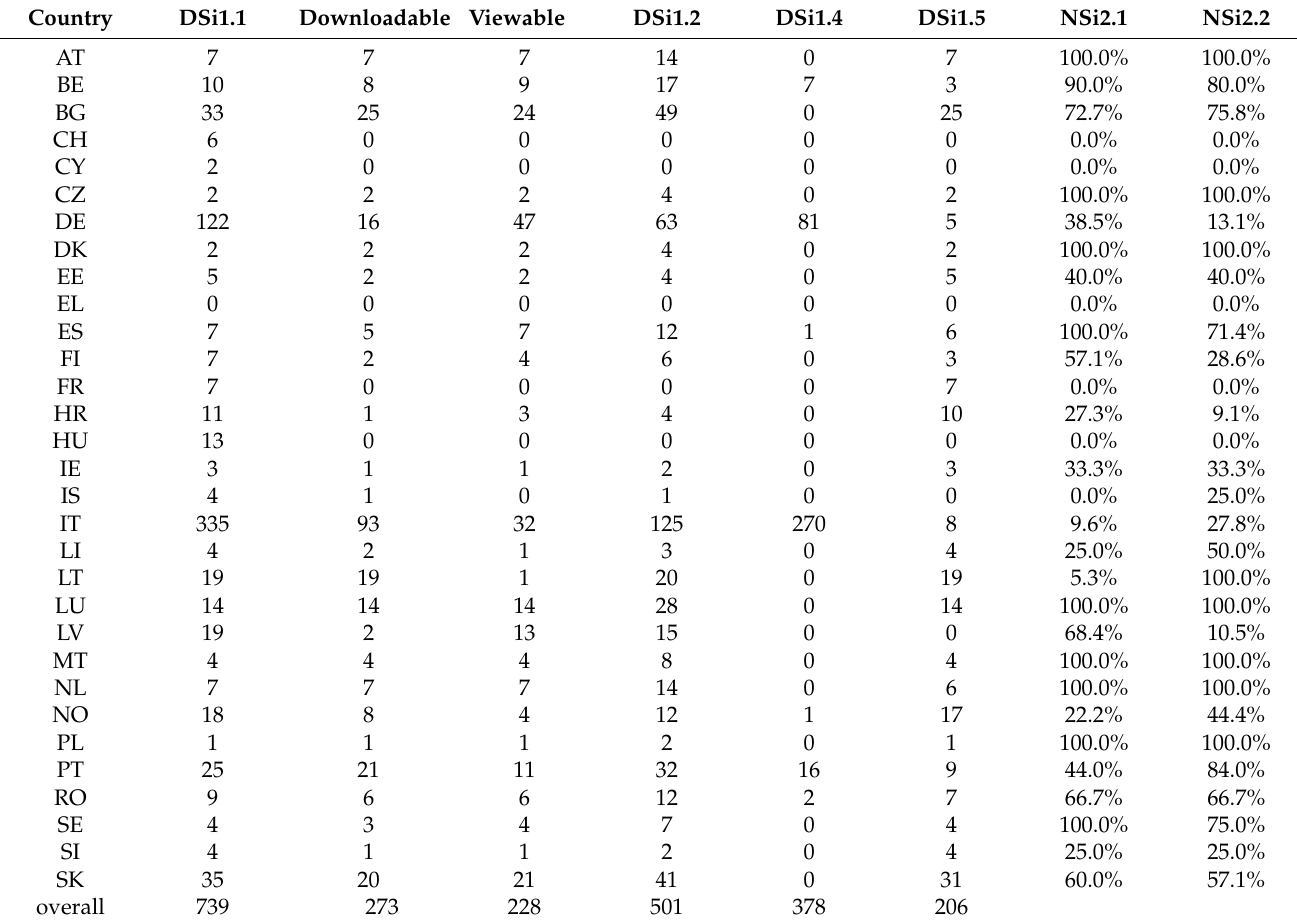
Table 1. Indicators of availability for